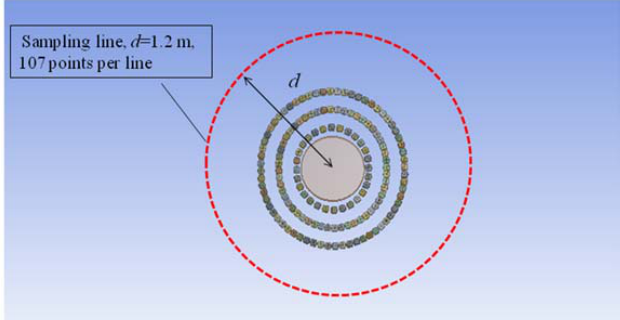
Figure 18. The sampling line positions for polar scattering pattern evaluation. The line is sampled around the object to investigate the scattering polar pattern. Appl. Sci. 2017 , 7 , 456